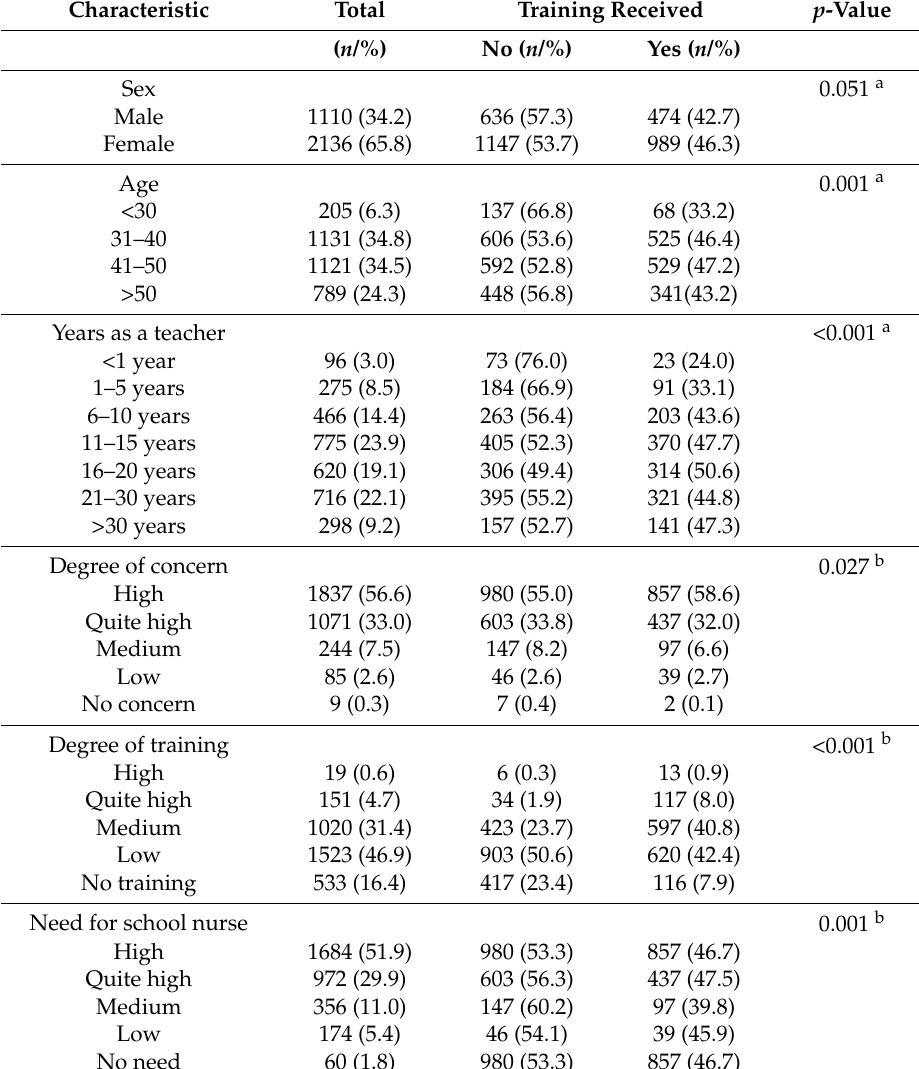
Table 1. Relation between teacher profile and training